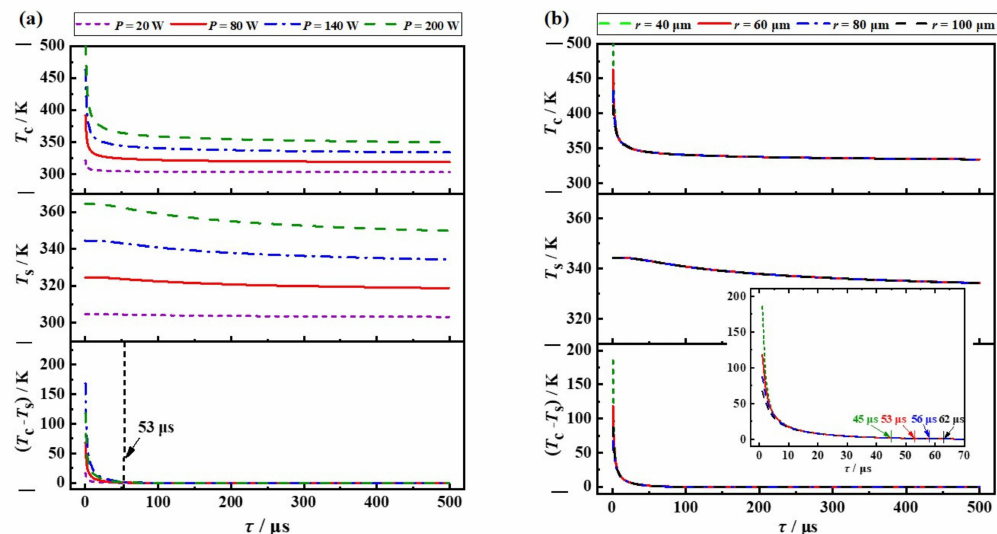
Figure 4. Temperature variation in diamond in the cooling process with ( a ) different absorbed power (60 µ m thermal radius), and ( b ) different thermal radius (140 W power), respectively.